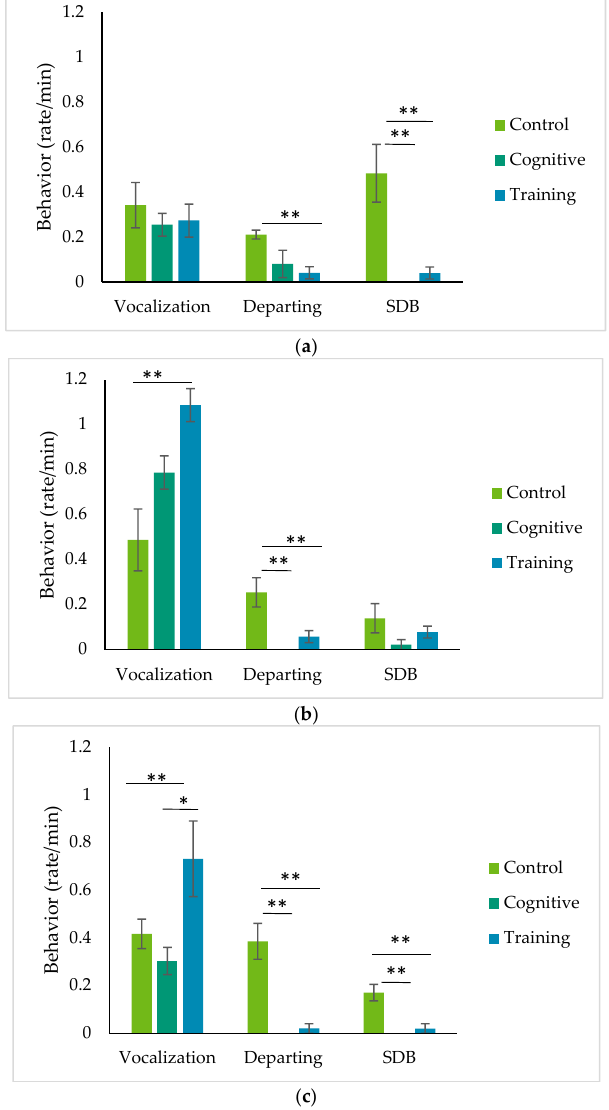
Figure 4. Rates of all-occurrence behaviors (mean ± standard error) including grumble vocalizations (vocalization), mesh depart (departing) and self-directed behavior (SBD) during two types of human–animal interactions and a control condition for ( a ) Chip; ( b ) Pende; and ( c ) Kongo. ** Indicates a significant di ff erence of p < 0.05 and * indicates a trend (0.05 ≤ p < 0.1) between conditions connected by a line based on Wilcoxon signed rank tests with Monte Carlo